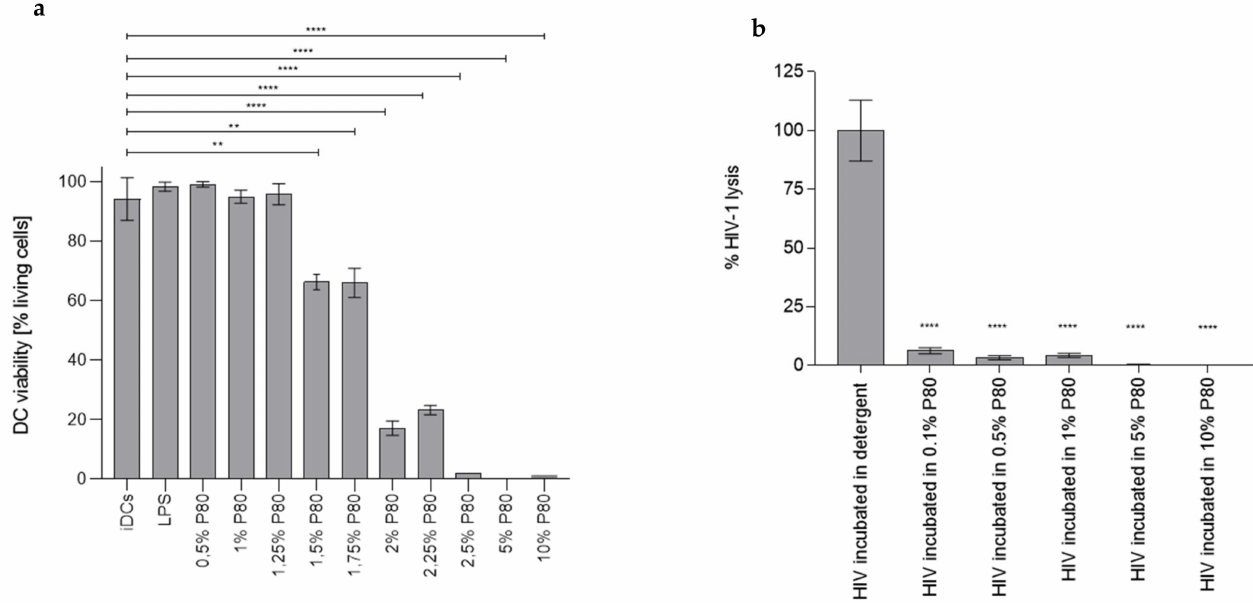
Figure 1. ( a ) DC viability is not affected up to 1.25% P80 natural essence. DCs exposed to various P80 natural essence concentrations (0.25–10%) or LPS as a positive control for DC stimulation were analysed for their viability on 2 days post-infection (dpI). P80 concentrations 1.5% to 10% significantly decreased DC viability. These data were obtained in three independent experiments and a summary of all experiments is illustrated. Statistical differences were analysed using GraphPad Prism software and one-way ANOVA with Dunnett’s post-test. ** p < 0.01, **** p < 0.0001 ( b ) P80 natural essence does not induce viral lysis. HIV-1 (1 µ g p24/mL) exposed to various P80 natural essence concentrations (0.1–10%) was analysed for viral lysis induced by P80. As illustrated below, P80 had only little effect on the virus and the virolysis induced by all P80 concentrations was significantly lower ( p < 0.0001) compared to the detergent control set as 100%. The experiment was repeated three times independently and a summary is depicted. Statistical differences were analysed using GraphPad Prism software and one-way ANOVA with Dunnett’s post-test. **** p <